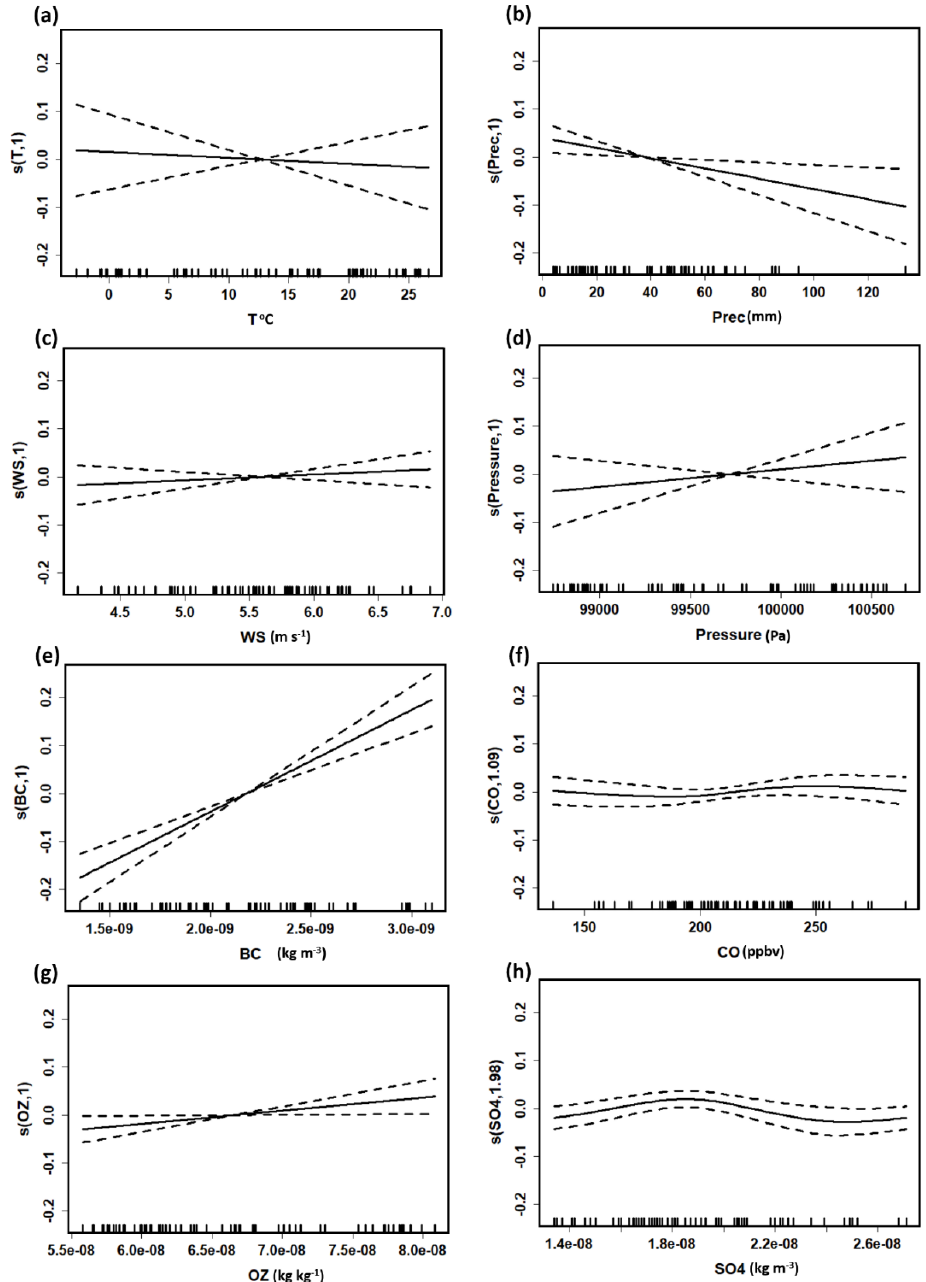
Figure 12. Generalized additive model (GAM) dependency analysis for PM 10 concentration. Re- sponse curves of PM 10 concentration to changes in ( a ) air temperature, ( b ) precipitation, ( c ) wind speed, ( d ) air pressure, ( e ) BC, ( f ) CO, ( g ) ozone mass mixing ratio, and ( h ) SO 4 . The y-axis represents the smoothing function values (example s(T) is the trend in PM 10 concentration when air tempera- ture changes, and the number (1) is the degree of freedom for the trend. The x -axis represents the measured values of the influencing factor, the solid line indicates the trend in PM 10 concentration with the change in influencing factors, and the dashed lines surrounding the solid line indicate the 95% confidence intervals.